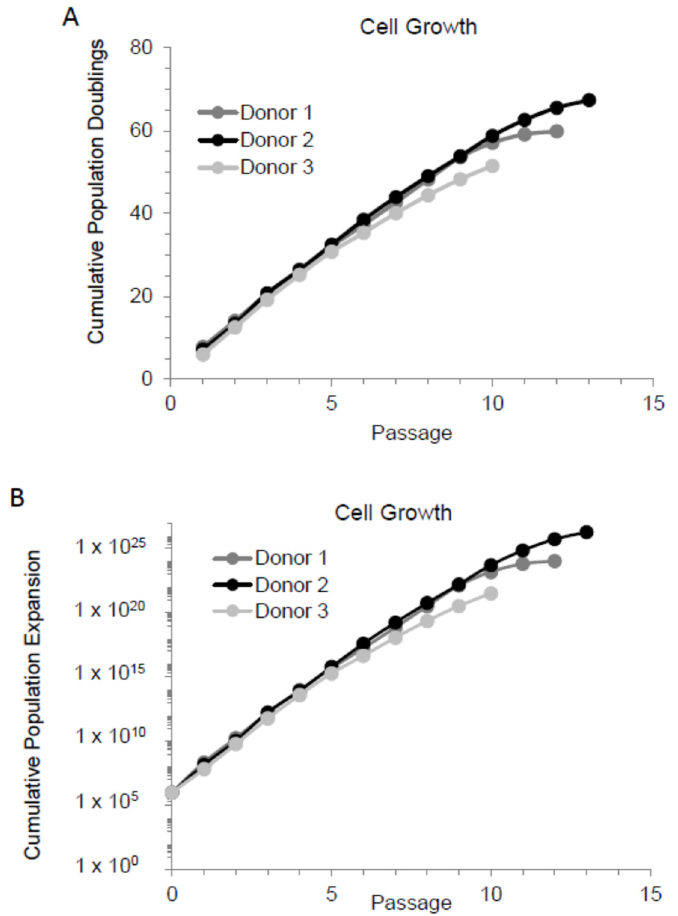
Figure 1. Mesenchymal stem cells (MSCs) produce up to 10 25 cells from a small bone marrow aspirate. MSCs from three di ff erent donors were cultured in low density and passaged every seven days. Cells were counted and seeded in a low density for the next passage. This was repeated until the cell number did not double during the seven days growth. ( A ) Cell growth as cumulative population doublings. ( B ) Cell growth as cumulative population expansion.